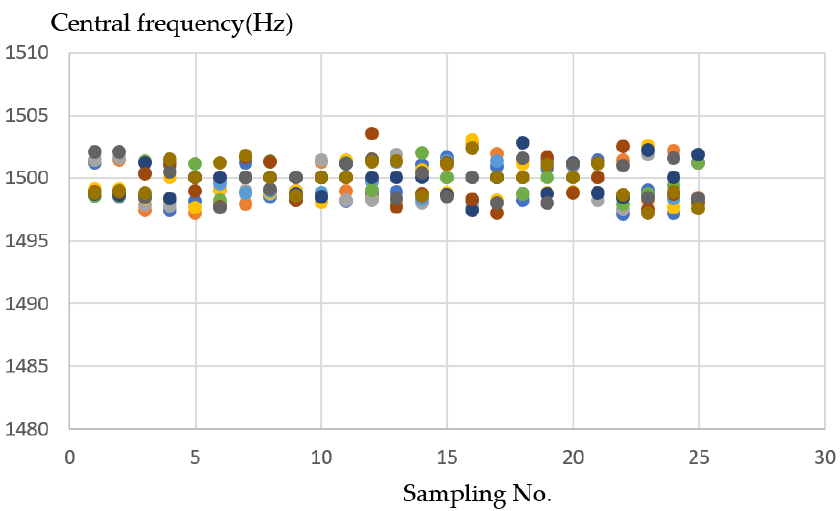
Figure 18. Ten sample frequency results from clustering by K-means for Styrofoam material.